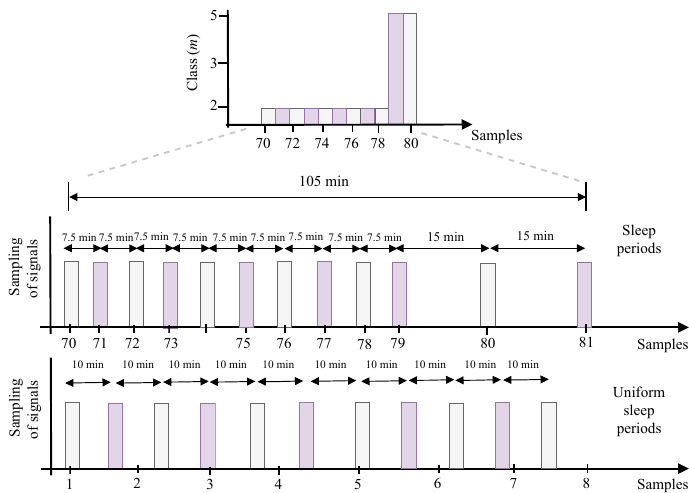
Figure 11. ML-decision tree and uniform power management comparative analysis for test scenario 2. Considering the same samples marked on the square red of Figures 8 and 10, the results on both test cases demonstrate the smart and adaptive behavior of the decision tree-DPMS.